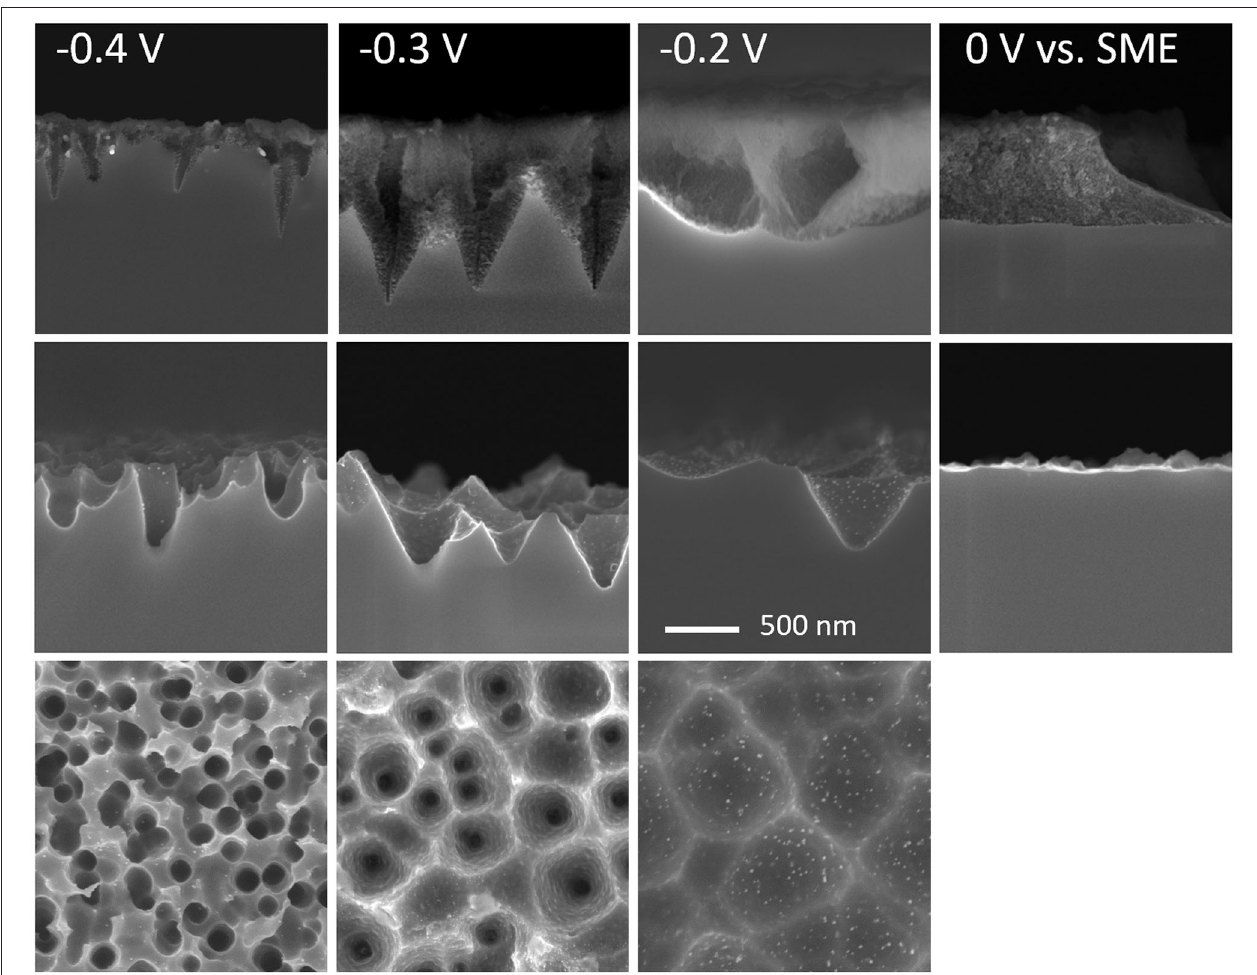
FIGURE 6 | SEM images of cone-shaped pores formed in p-type silicon by MACE with silver nanoparticles in HF-H 2 O 2 with in addition an external anodic potential. Same magnification for all images. Top row: cross section views after etching. Middle and bottom rows: after etching and porous silicon removal in HF-HNO 3 in cross section and plane view, respectively. Scale bar: